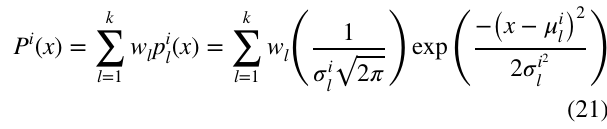
( k + l ) set of solutions, the fittest k solutions are kept in the matrix, while l solutions are discarded. These k solutions are sorted and kept in the matrix depending on their weight w k .